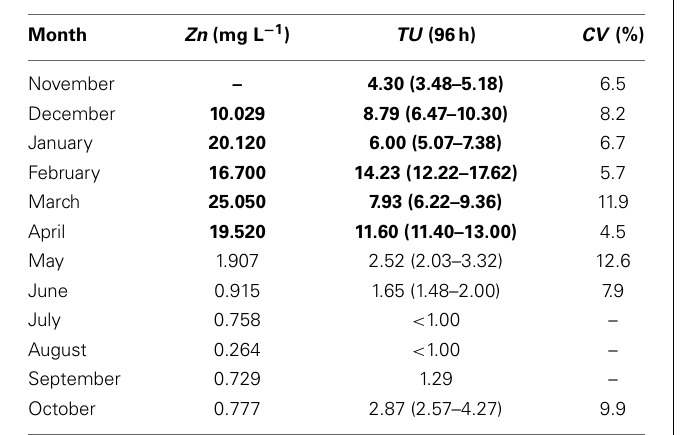
Table 3 | Toxicity and Zn concentrations of wastewater treatment plant final effluents.